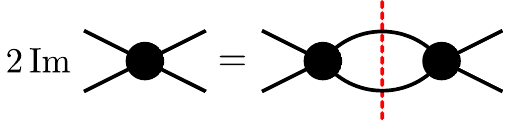
Fig. 3 Connectionbetweenthethreereferenceframesforthe ( 32 ) 1 → ( 12 ) 3 system. The total reaction plane in the CMF is shown in gray, and the initial and final IRFs are shown in blue and green, respectively. The